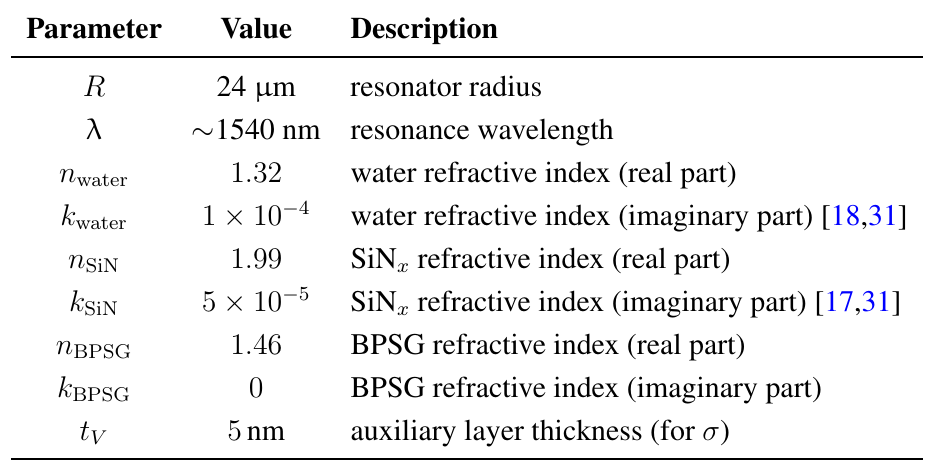
Table 1. Parameters used in the optimization study. BPSG, borophosphosilicate